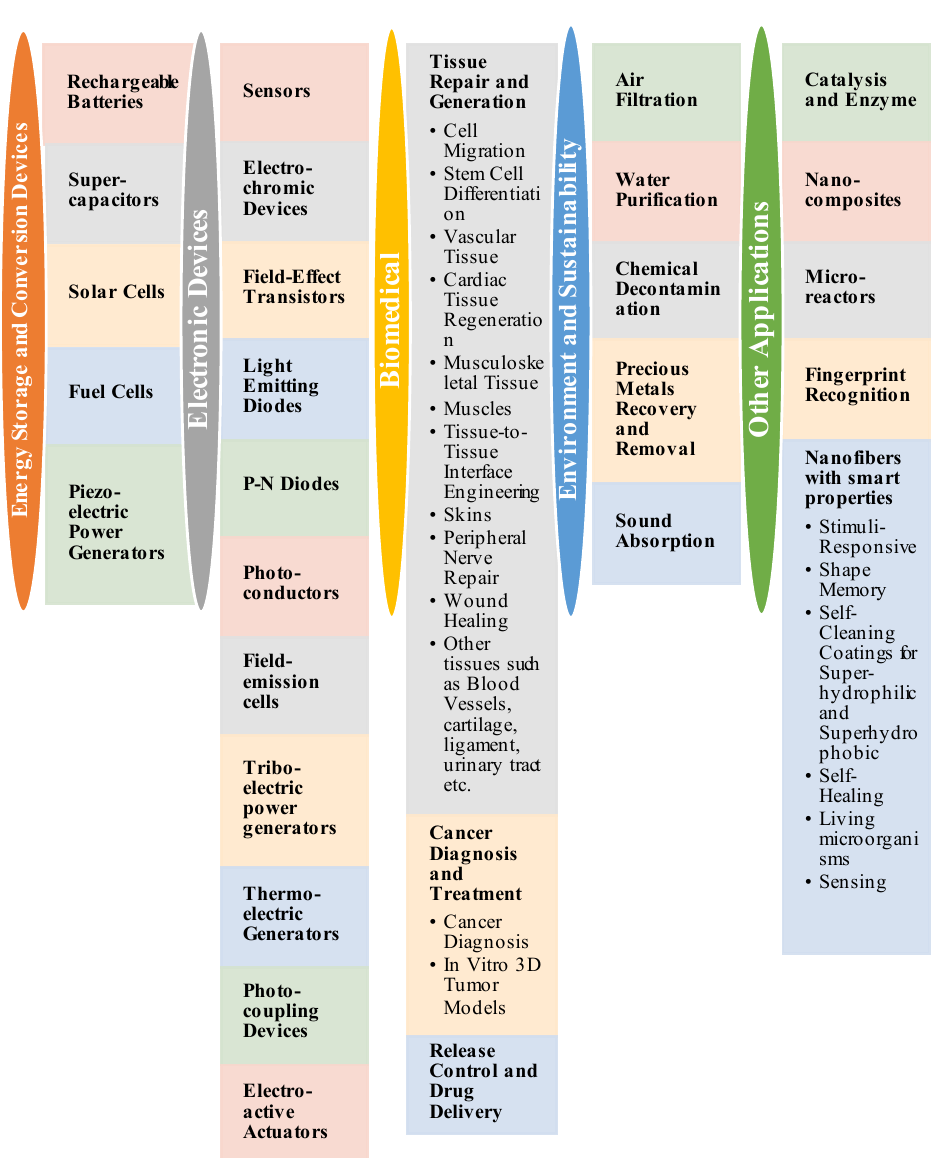
Figure 16. Various applications of electro-spun